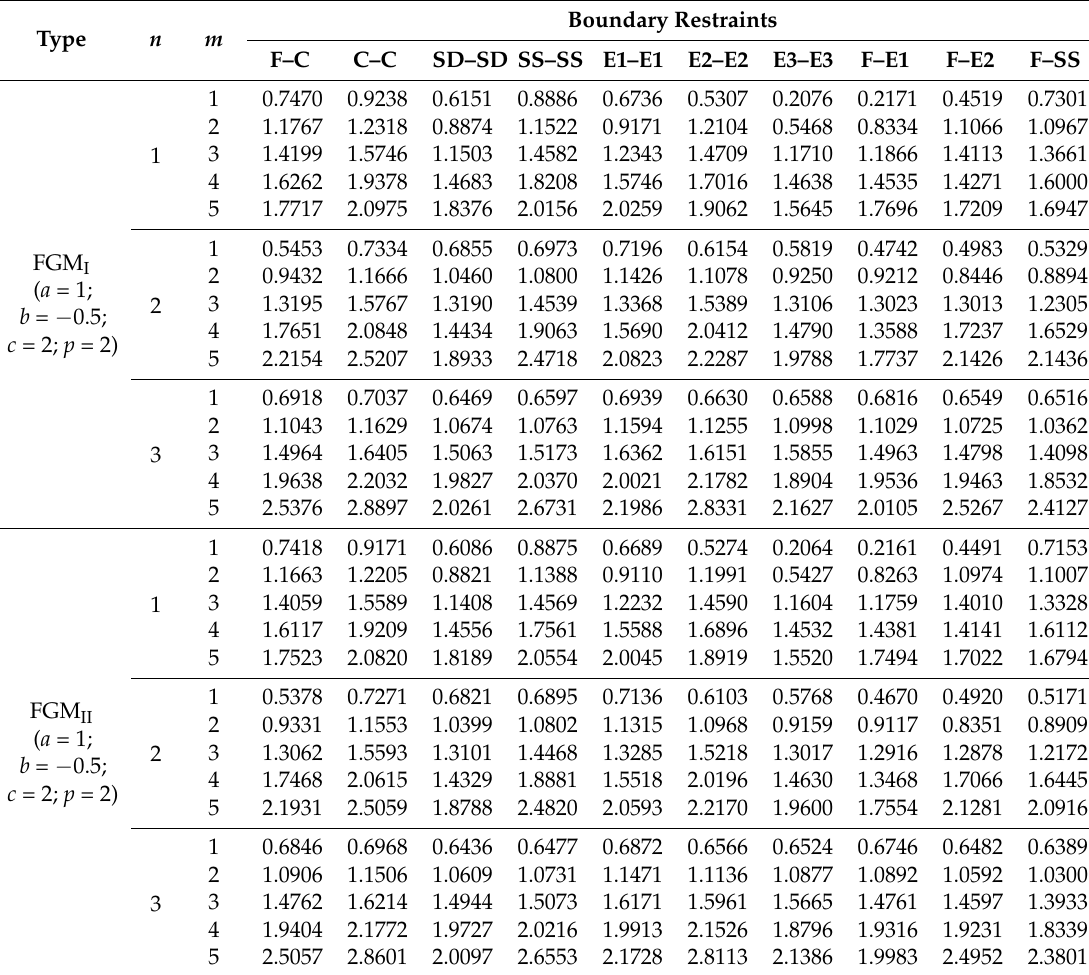
Table 5. Frequency parameters Ω of stepped paraboloidal